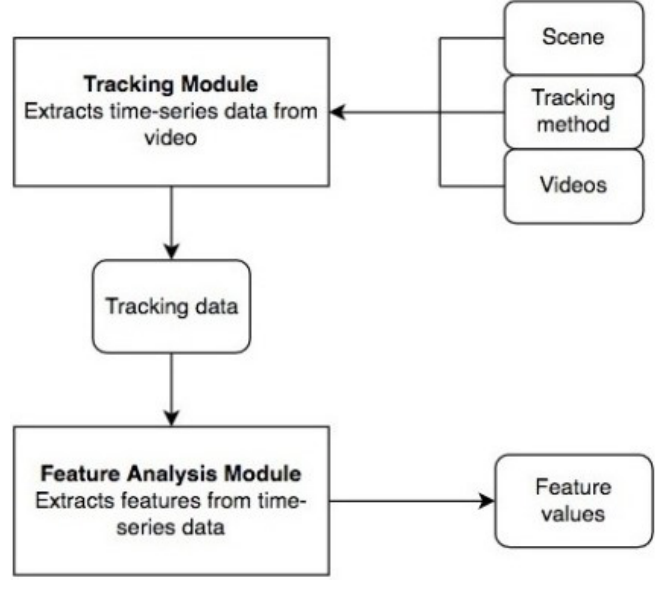
Figure A1. BLYZER